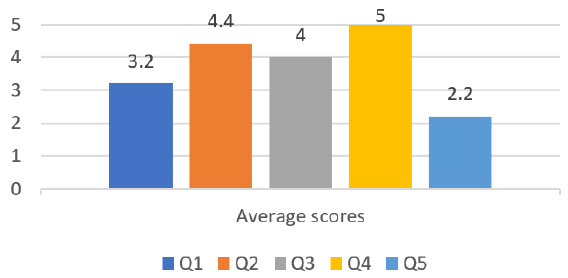
Figure 13. Results of survey